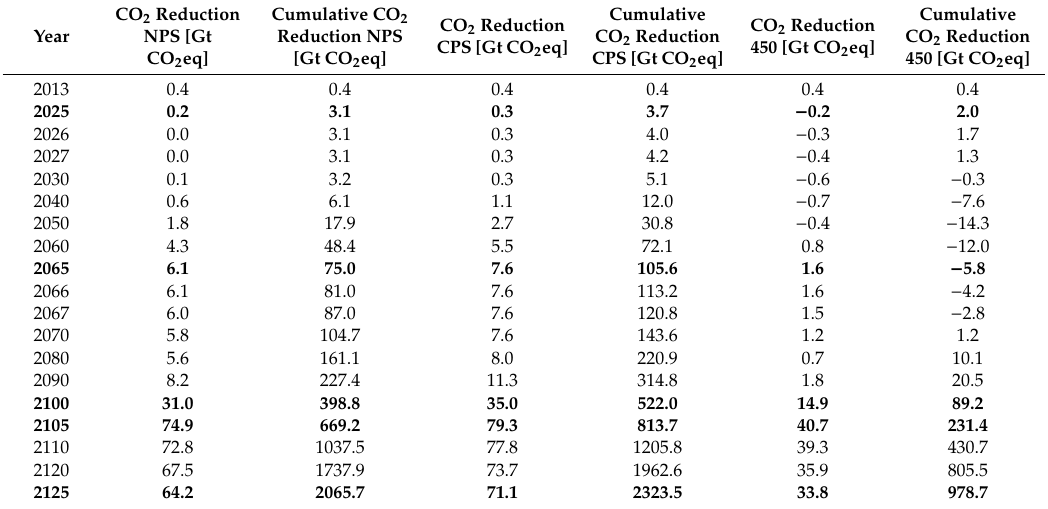
Table 10. Possible CO 2 emission reduction for scenario S2, sub scenario B.